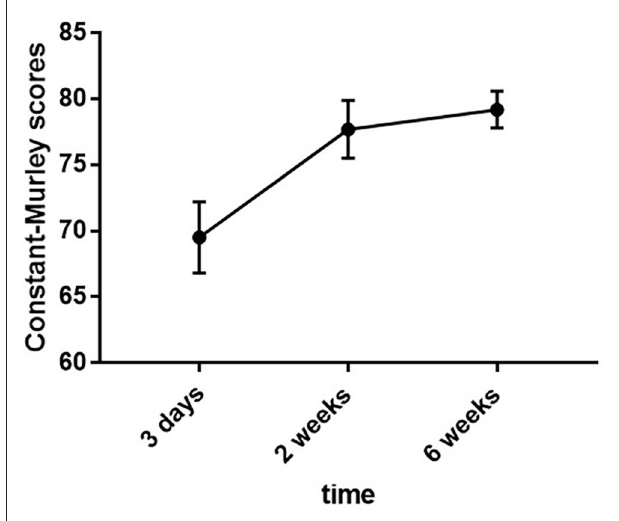
FIGURE 2 | Trends in scores for the ISP patient at three postoperative time points.